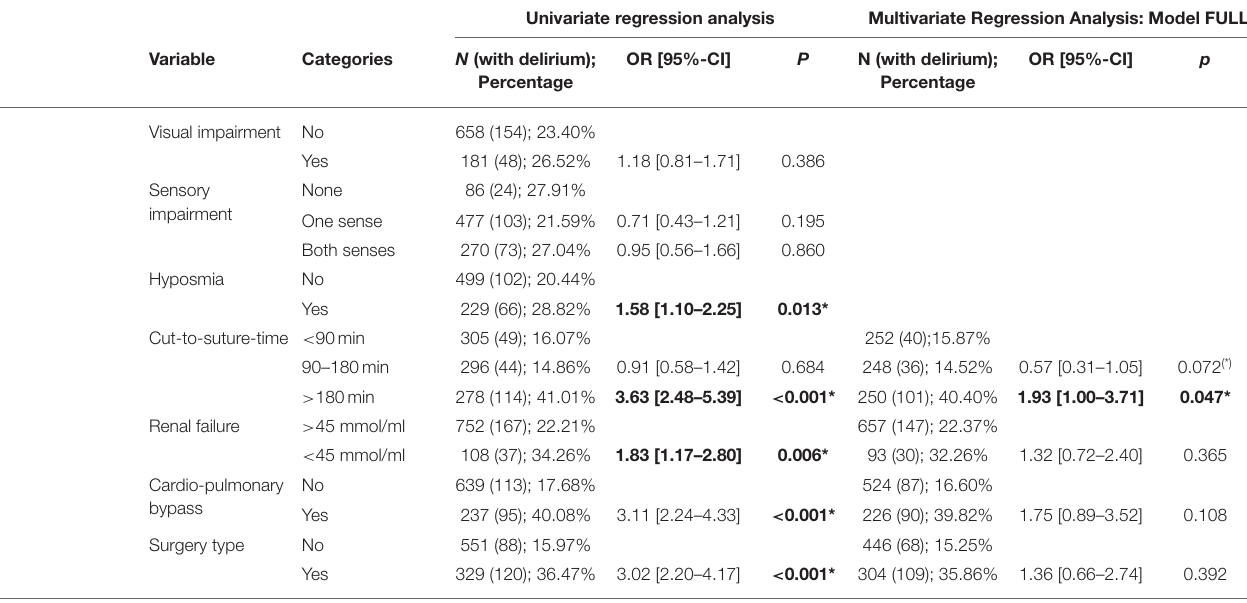
Age per se , excessive alcohol consumption, active smoking, and visual or hearing impairments were not predictive in the